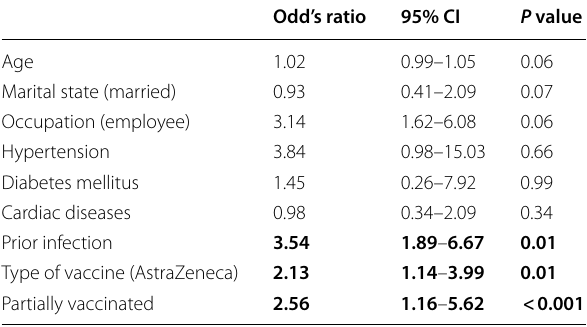
Table 8 Regression analysis for prediction of post-vaccine COVID-19 infection ( N 70) among all vaccinated participants = ( N =